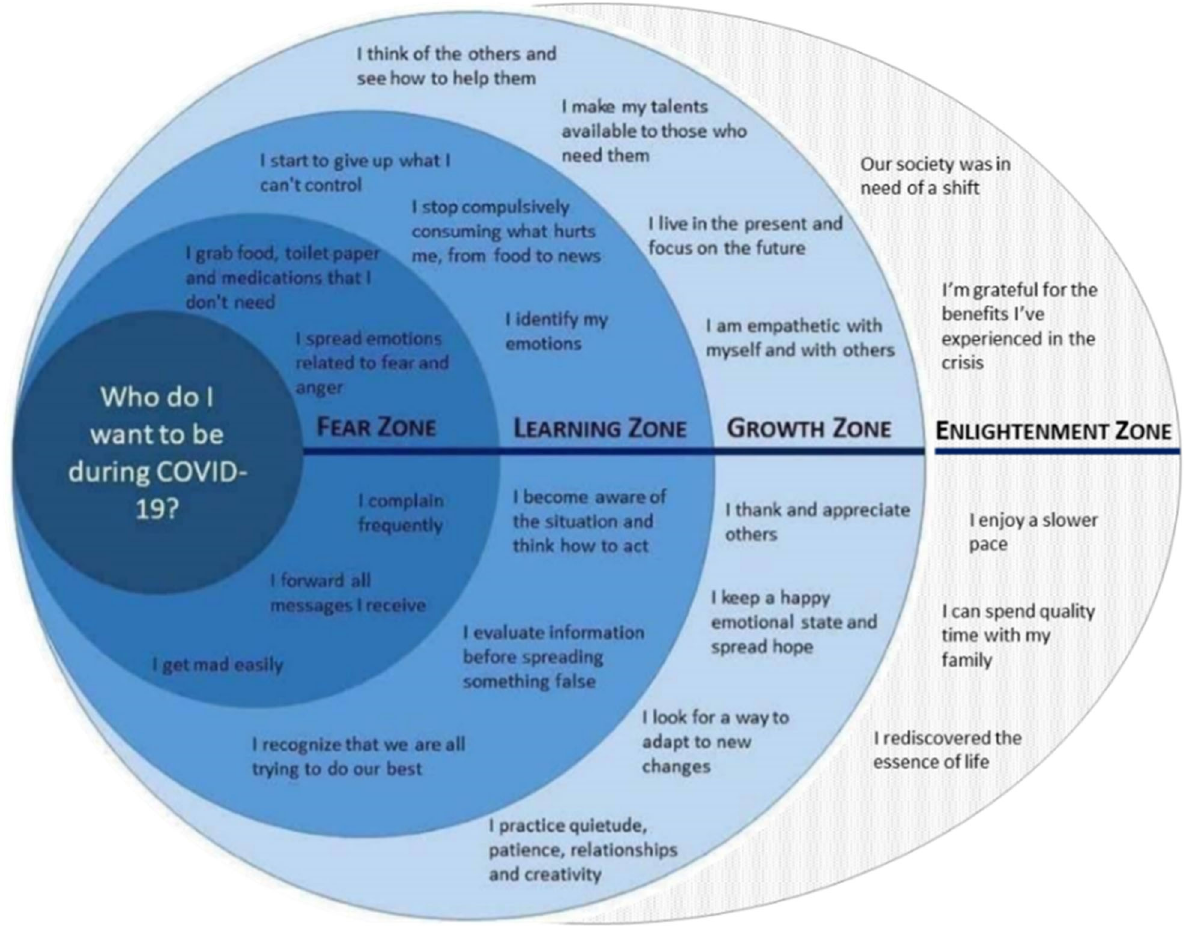
Fig. 11 Conceptual zones in the metaphorical reframing process. (source: https://knowledge.insead.edu/blog/insead-blog/from-fear-to-enlightenment-